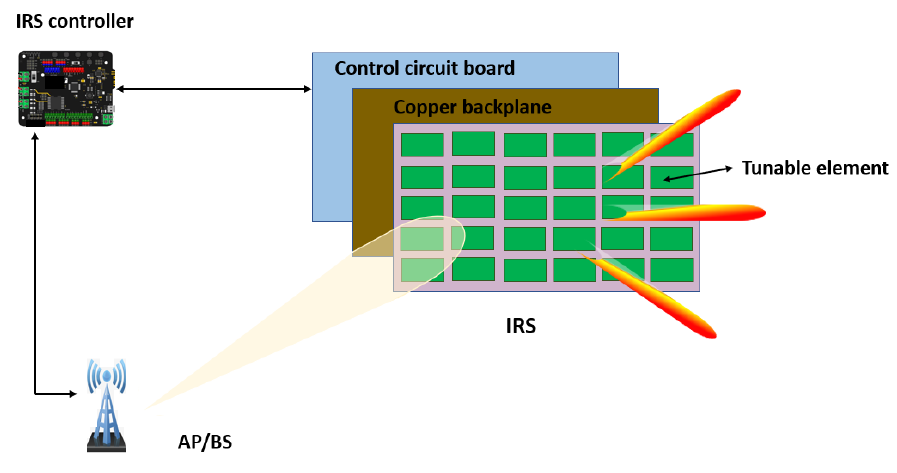
Figure 4. Architecture of an